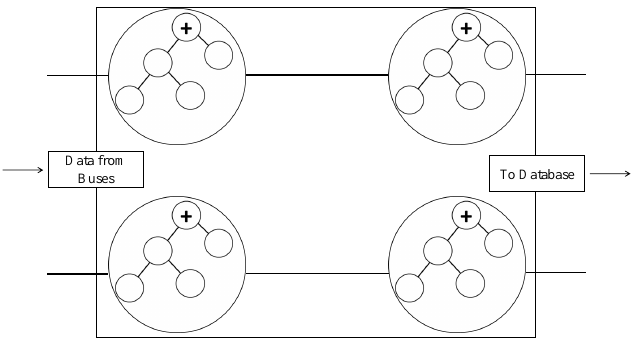
Figure 8. Message queuing telemetry transport (MQTT) clusters: Every node maintains a tree of